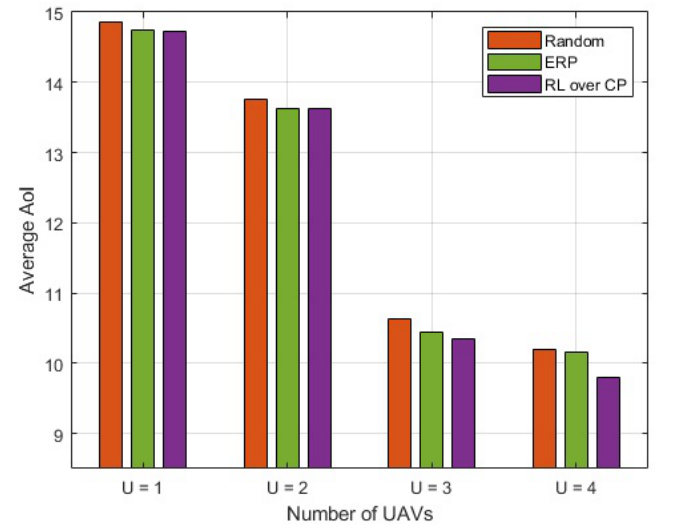
Figure 4. Average AoI of